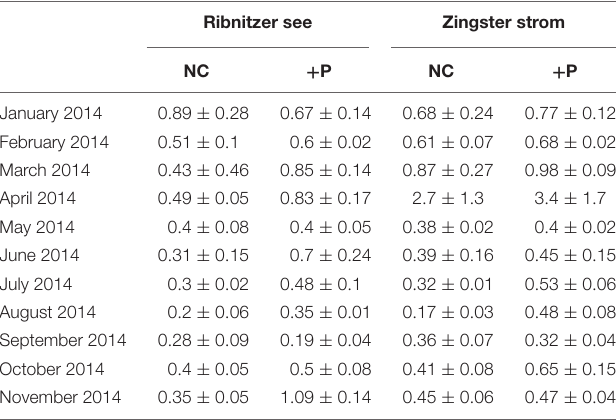
TABLE 2 | Mean growth rates of fertilized and unfertilized samples of the Ribnitzer See and Zingster Strom during January 2014 to November 2014. Ribnitzer see Zingster